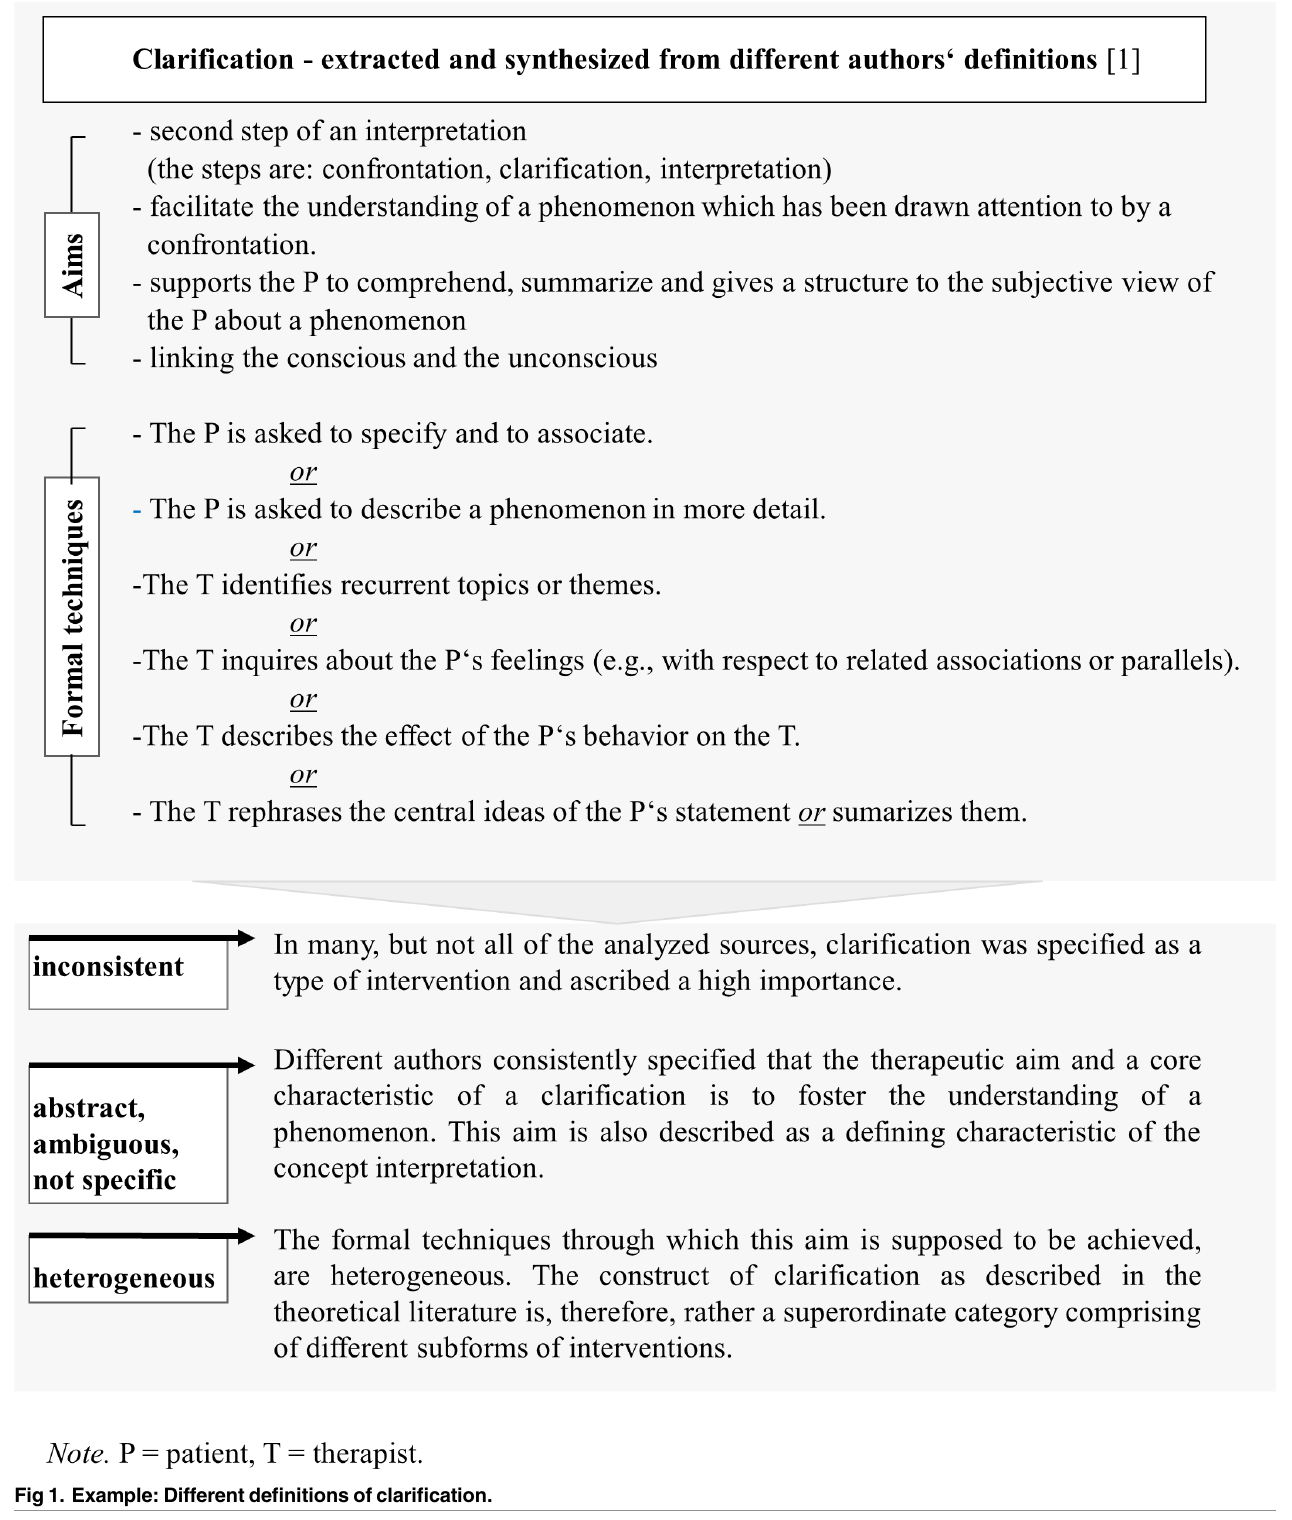
PLOS ONE | https://doi.org/10.1371/journal.pone.0182949 August 24, 2017 3 /